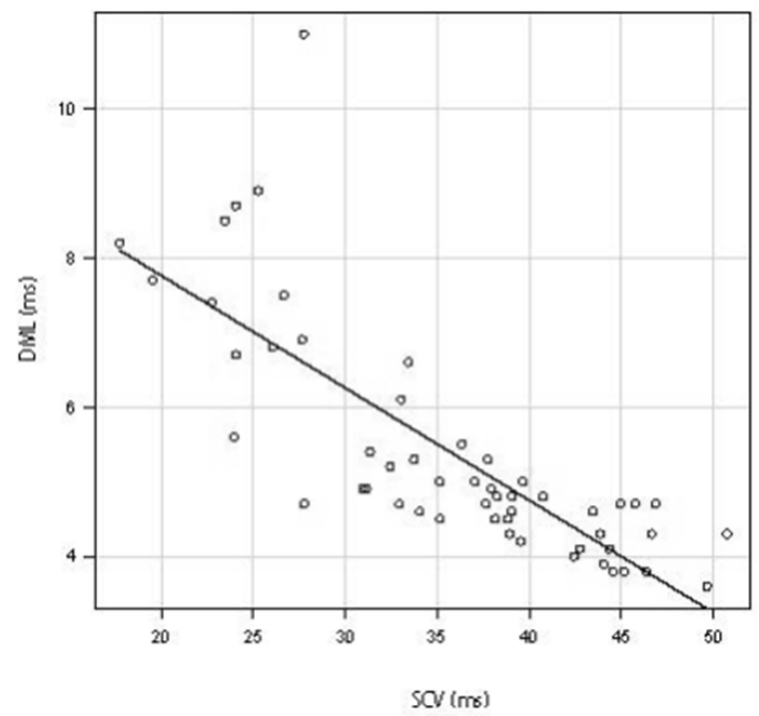
Figure 3. Scatter diagram between SCV and DML in the diabetes patients. The straight line shows the correlation between SCV and DML. Abbreviations: DML, distal motor latency; SCV, sensory nerve conduction